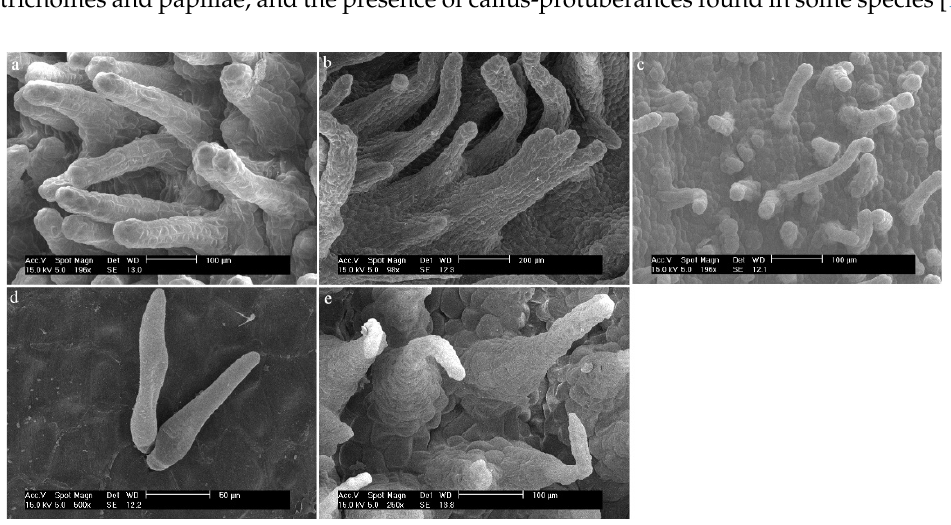
Figure 1. Terminology for parts of the labellum used in the Results section.